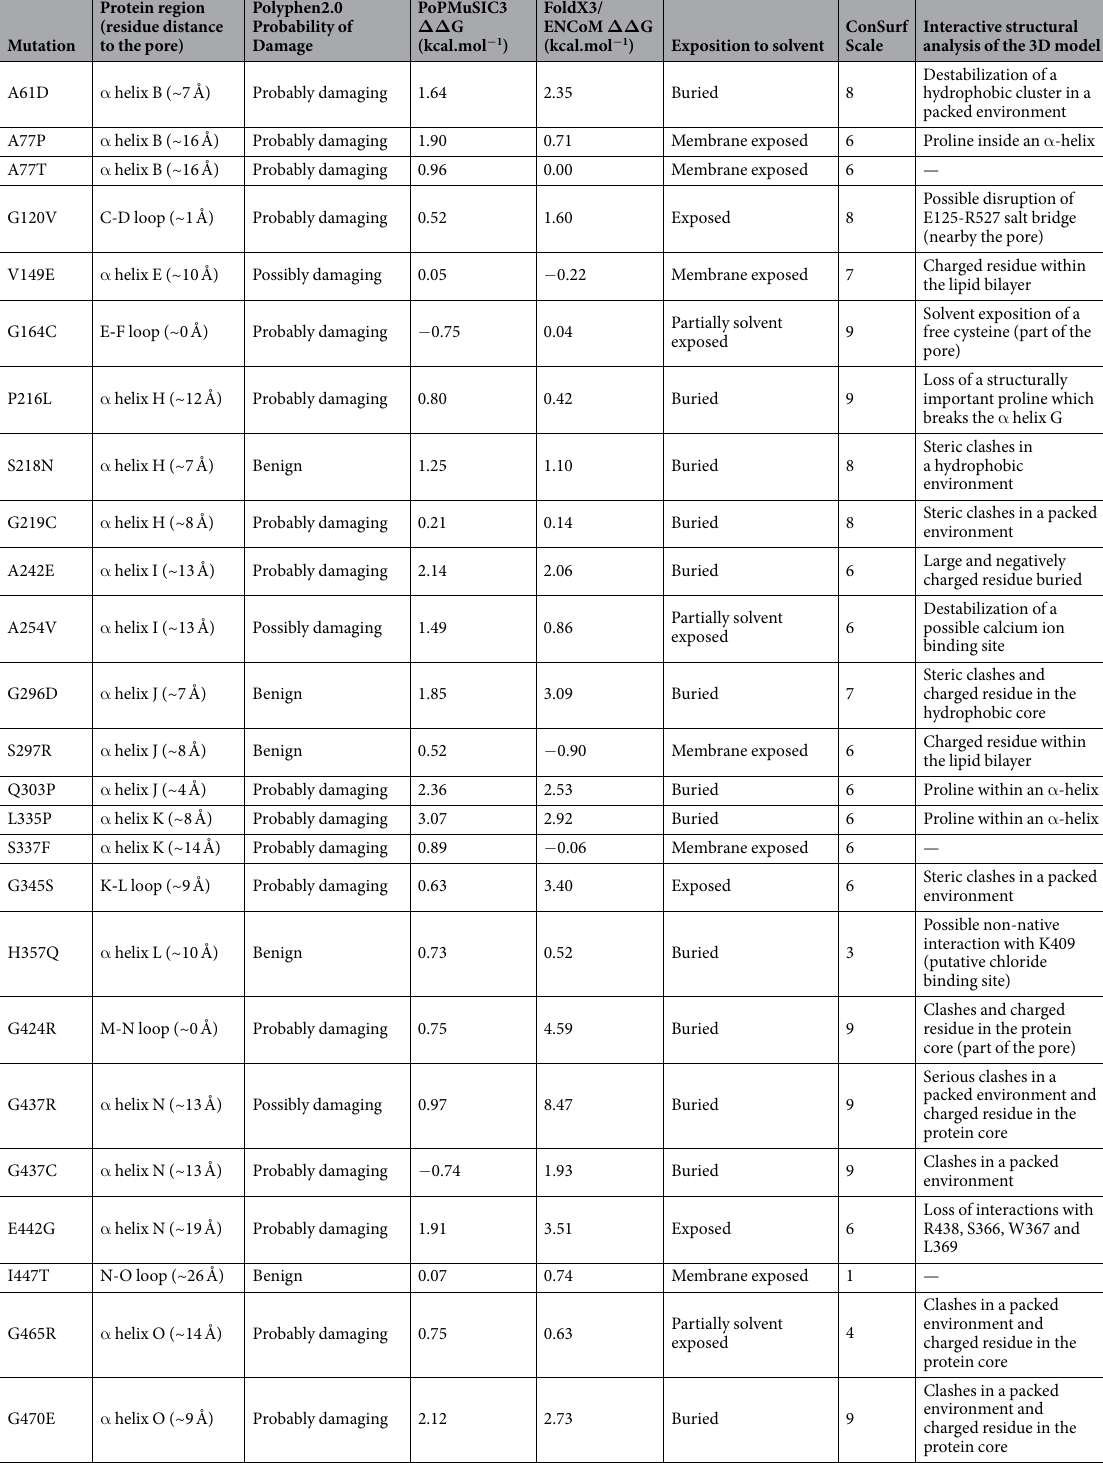
Table 2. ClC-Kb mutations possibly involved in the Bartter syndrome type 3 in the intra-membrane region essentially lacking experimental